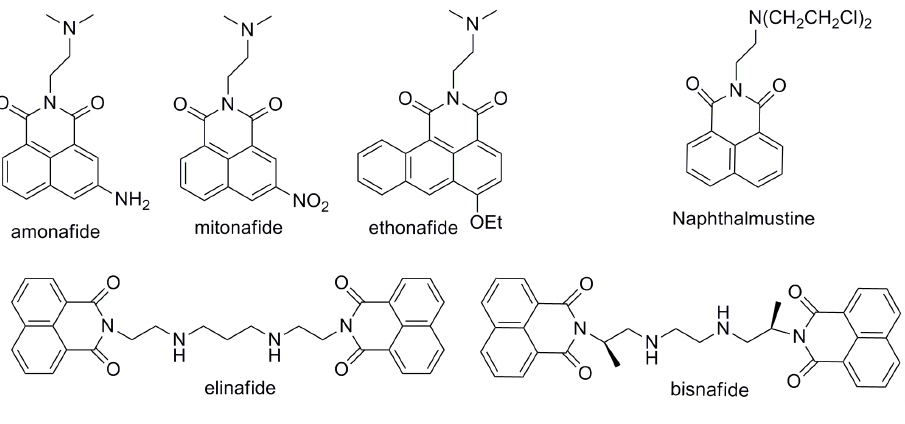
Figure 2. Structures of naphthalimides and N -mustard